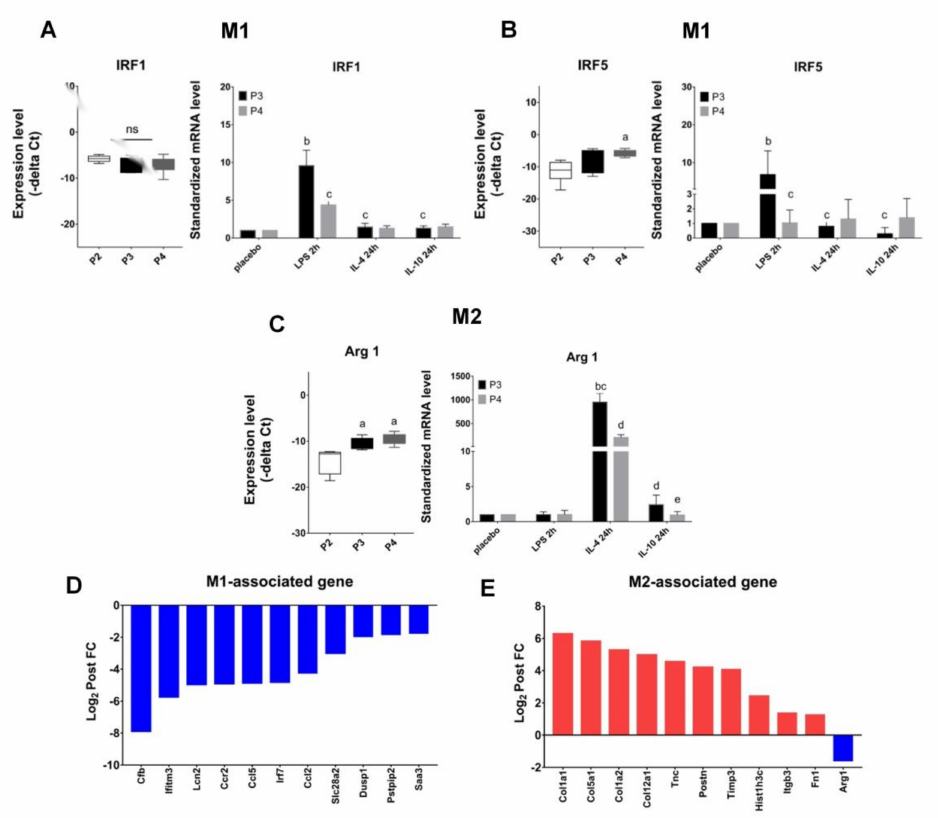
Figure 4. Trend for macrophages to M1/M2 polarization by further LPS, IL-4 or IL-10 stimuli. Macrophages collected from day 7 (P3) and day 21 (P4) culture were further stimulated with